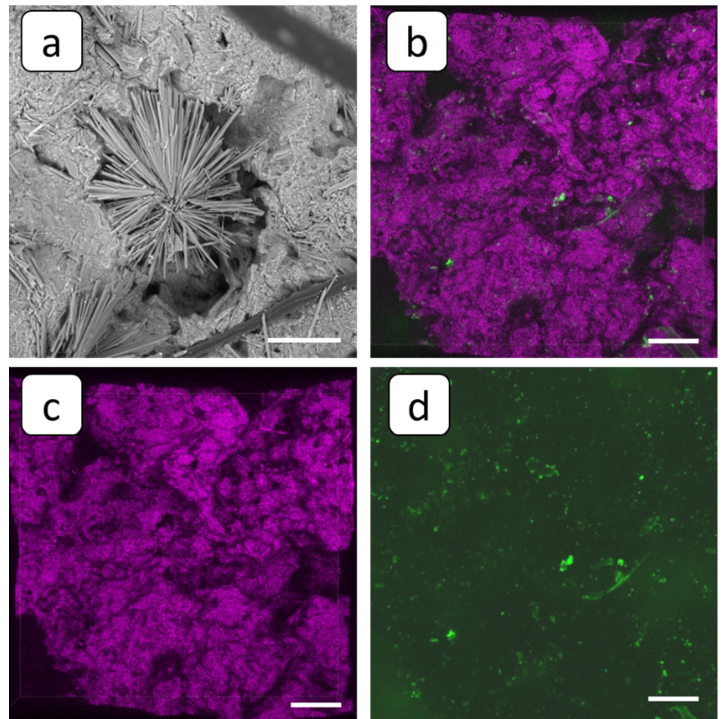
Figure 7. SEM ( a ) and FM 3D images ( b – d ) of the cation-exchange membrane MK-40 after the blank experiment, superposition of fluorescent and reflected light ( b ), and the same view in reflected ( c ) and fluorescent ( d ) light. Scale bar: 100 µm.